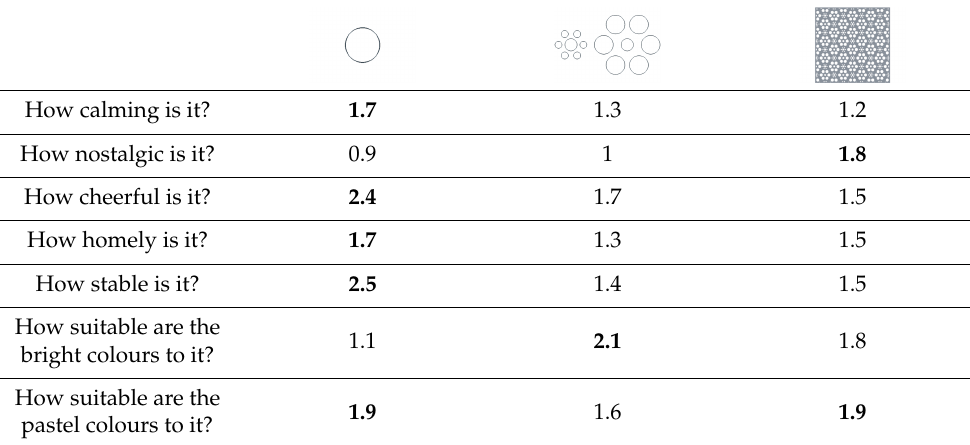
Table 5. Third pattern—node